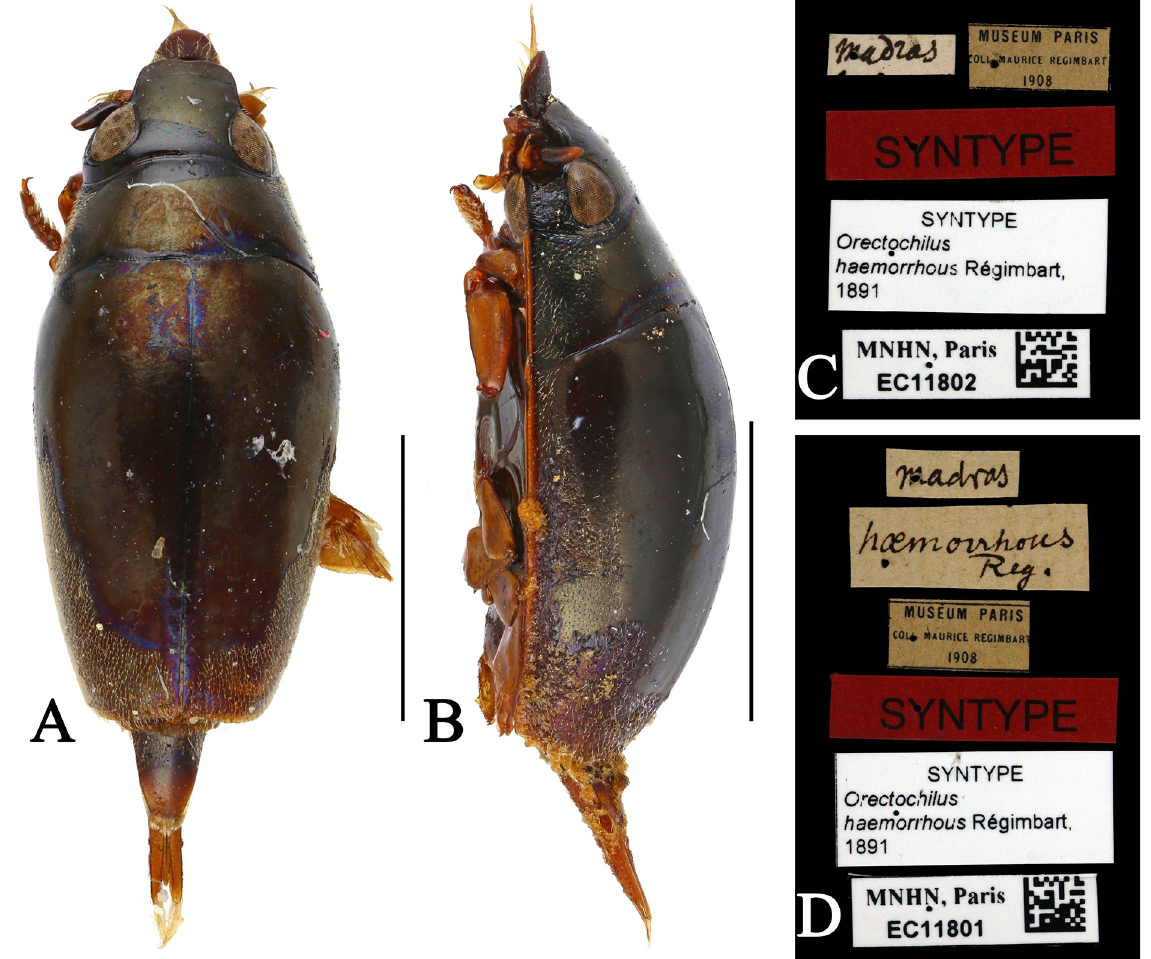
Fig. 14. Patrus haemorrhous (Régimbart, 1891), syntypes (MNHN). A . ♀, habitus, dorsal view. B . ♂, habitus, lateral view. C . Label of specimen A. D . Label of specimen B. Figures provided by Antoine Mantilleri. Scale bars = 2